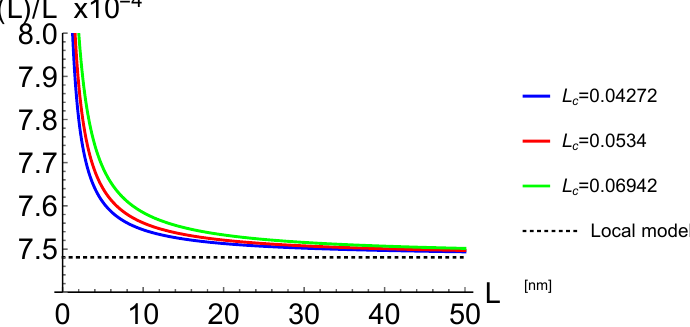
Figure 7. Plot of the non-dimensional maximum displacement u ( L ) / L of the NSG model vs. the SWCNT’s length L for the nonlocal parameter L c ranging in the set ( 0.04272,0.0534,0.06942 ) nm. The non-dimensional local maximum displacement (black dotted line) is 1/ AE = 7.48069 × 10 − 4 . The data of the SWCNT are: diameter d = 1.4132 nm, effective thickness t = 0.0617 nm and Young’s modulus E = 4880